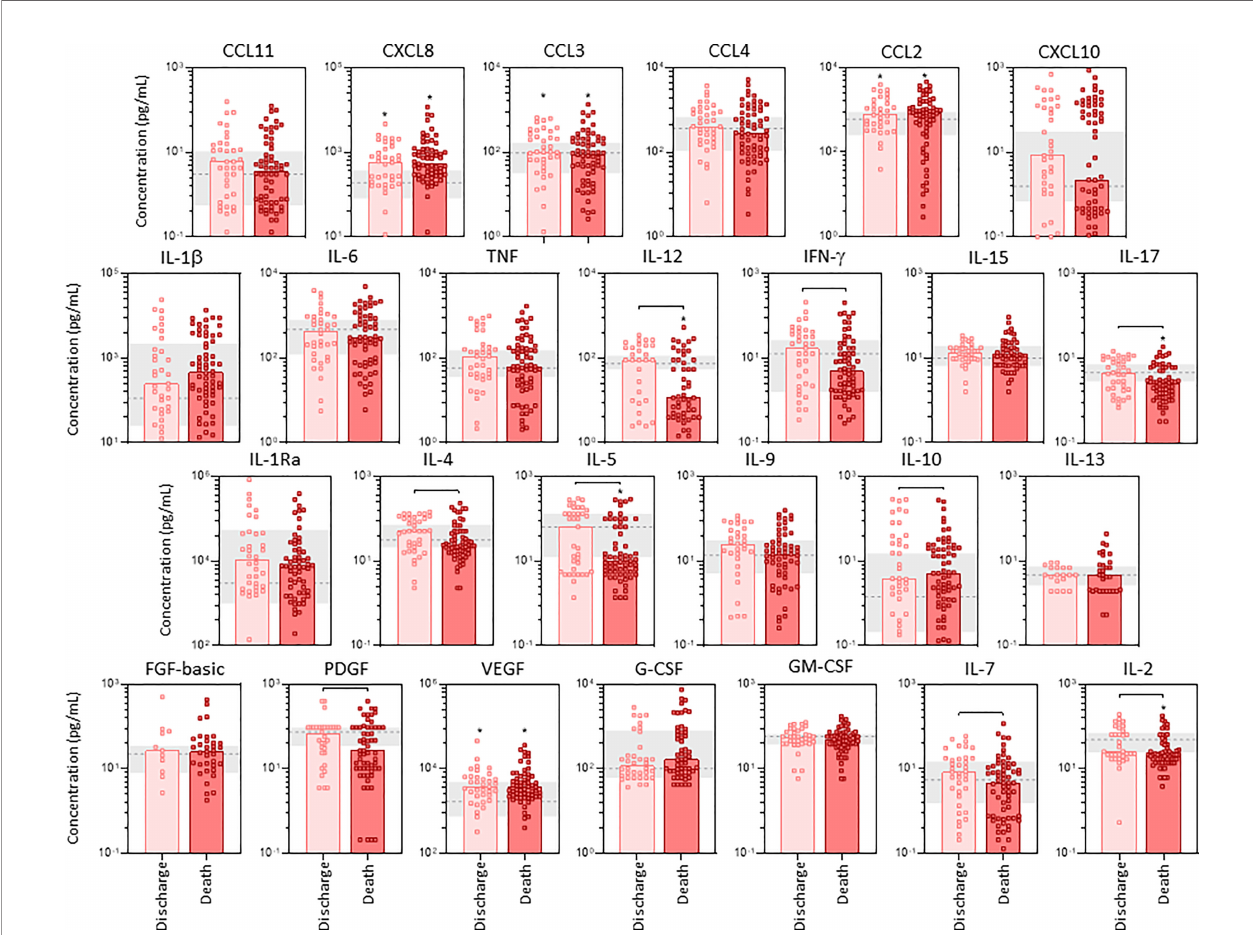
FIGURE 6 | Pro fi le of airway soluble immune mediators in tracheal aspirate samples from critically ill COVID-19 patients at ICU admission, according to disease outcome. The concentration of chemokines (CXCL8, CCL11, CCL3, CCL4, CCL2, CXCL10), pro-in fl ammatory cytokines (IL-1 b , IL-6, TNF, IL-12, IFN- g , IL-15, IL-17), regulatory cytokines (IL-1Ra, IL-4, IL-5, IL-9, IL-10, IL-13) and growth factors (FGF-basic, PDGF, VEGF, G-CSF, GM-CSF, IL-7 and IL-2) were quanti fi ed in tracheal aspirate samples from critically ill COVID-19 patients – “ COVID ” (n=103) at ICU admission (D0=baseline), further categorized according to disease outcome, referred as “ Discharge ” ( ■ , n = 37) or “ Death ” ( ■ , n = 66). The gray zone represents the reference interquartile range (25 th -75 th ) observed for non-infected patients “ NI ” (n=18). Measurements were carried by high-throughput microbeads array as described in Material and Methods section. The results are expressed in pg/mL and presented as scattering distribution of individual values over bar plots underscoring the median value on each bar. Signi fi cant differences at p < 0.05 are indicated by asterisk (*) as compared to NI and by connecting lines for comparisons between Discharge versus